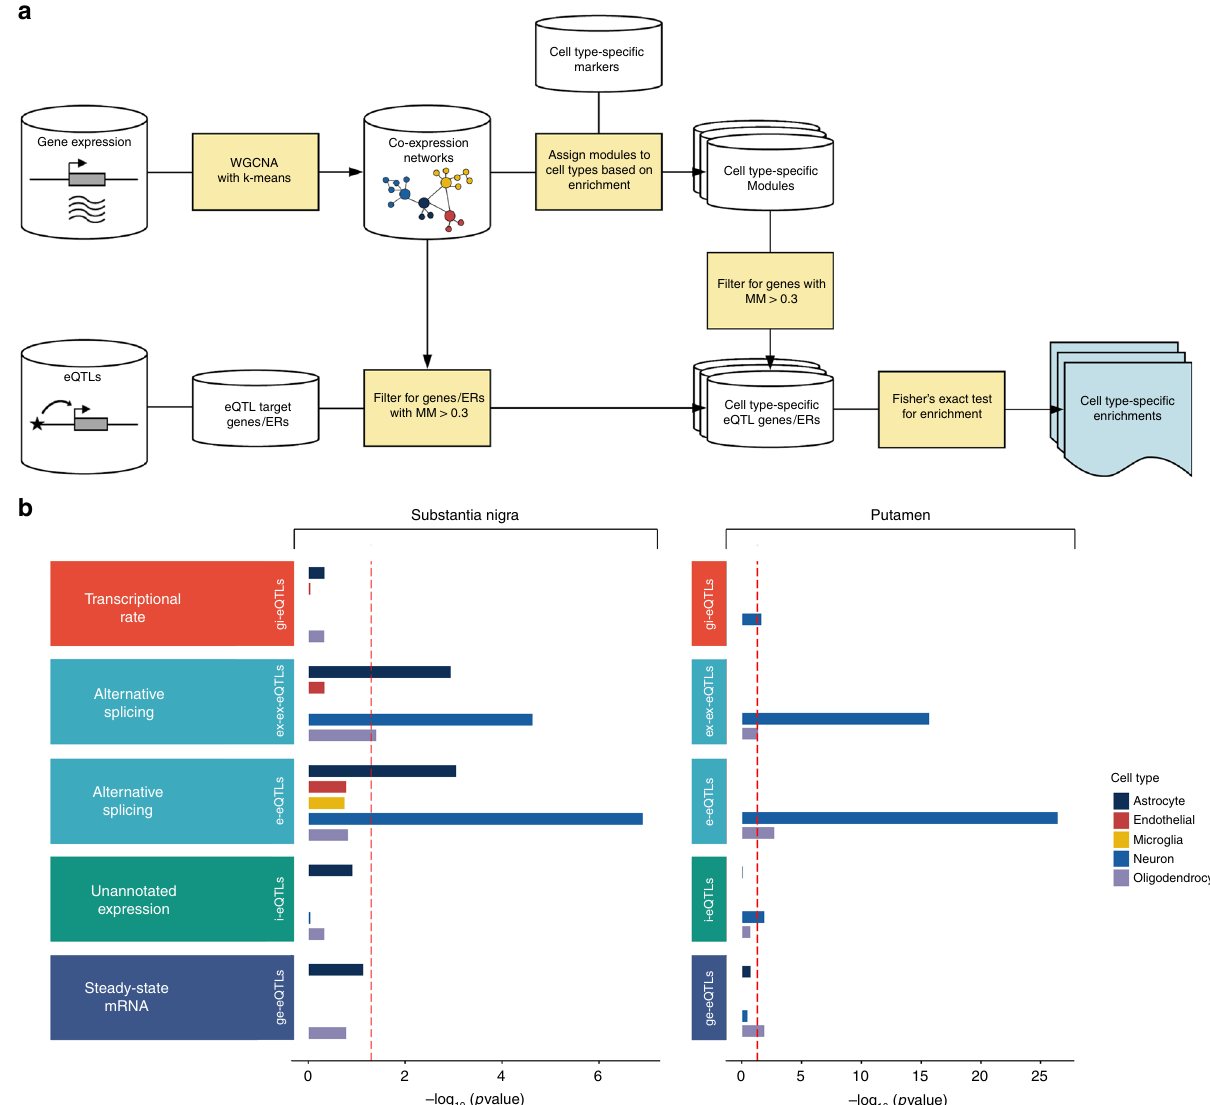
Fig. 4 Non-standard eQTL analyses produce additional biologically relevant information. a Schematic diagram showing the use of gene co-expression networks to assign eQTL target genes and unannotated expressed regions (ERs) to the cell type most likely to be driving gene expression in the tissue. We used the WGCNA R package 63 . b eQTL classes were variably enriched for genes with cell-biased expression, highlighting the importance of capturing this information. Enrichment of genes with cell-biased expression within eQTL targeted expression features was performed separately for each tissue and was determined using a Fisher ’ s Exact test and a signi fi cance cutoff of P < 0.05 (dashed red line at − log 10 ( P ) = 1.30). Genes assigned to modules signi fi cantly enriched for brain-related cell type markers and with a module membership of > 0.3 were allocated a cell type. Next, for each eQTL targeting a known genic region or an unannotated expressed region with high or moderate evidence linking it to a known gene, if the target gene was allocated to a cell type